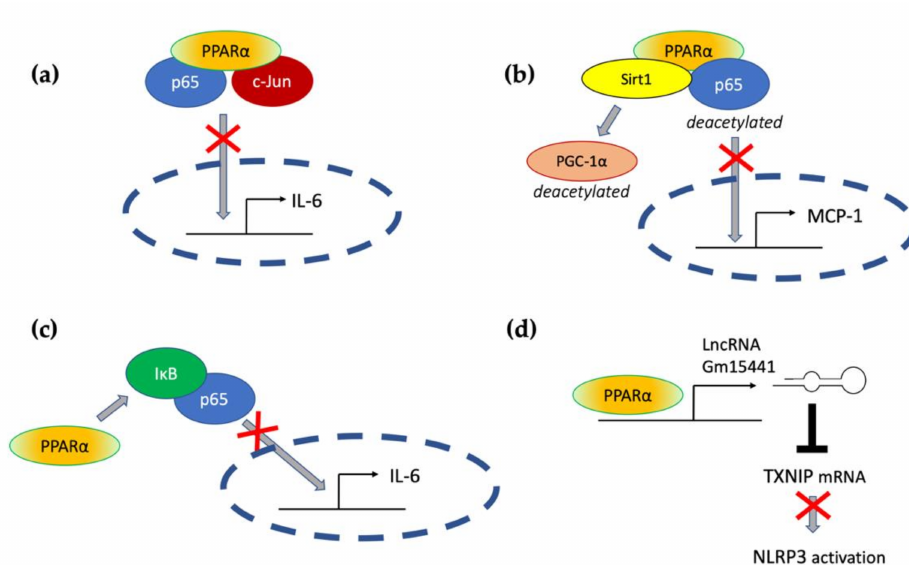
Figure 2. The molecular mechanisms responsible for PPAR α -mediated suppression of proinflammatory signaling pathways (see the main text for explanation) ( a ) through a direct interaction with p65 and c-Jun, ( b ) through interaction with Sirt1 and subsequent deacetylation of p65, ( c ) through activation of I κ B, and ( d ) through transactivation of long noncoding RNA Gm15441, which interferes with the stability of thioredoxin-interacting protein (TXNIP) mRNA and blocks NLRP3 inflammasome